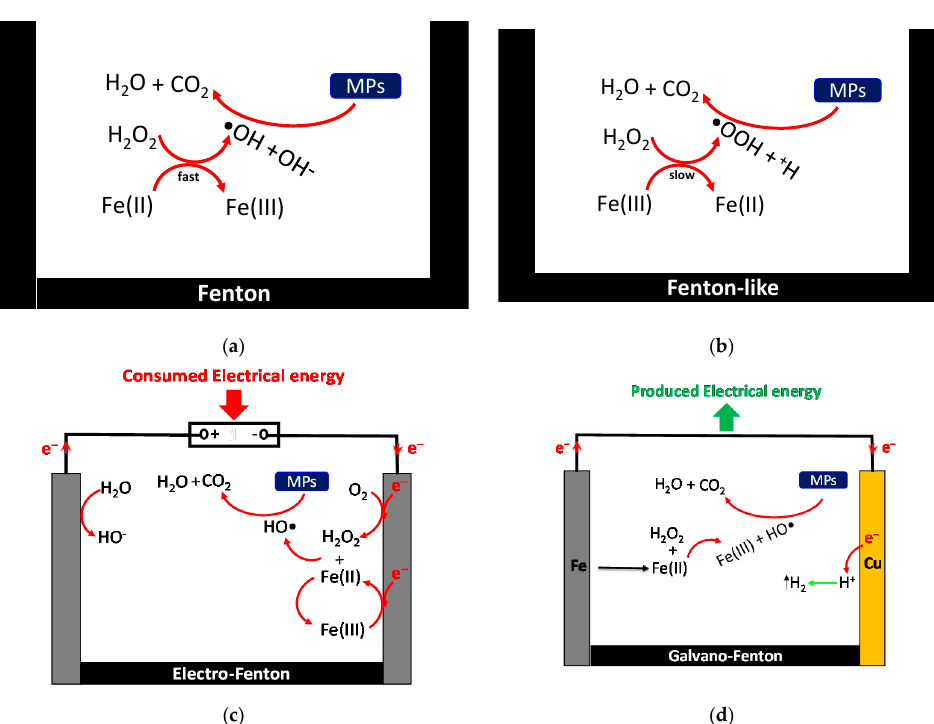
Figure 1. Basic reactional mechanisms describing classic Fenton ( a ), Fenton-like ( b ), electro-Fenton ( c ), and Galvano-Fenton ( d ) processes.